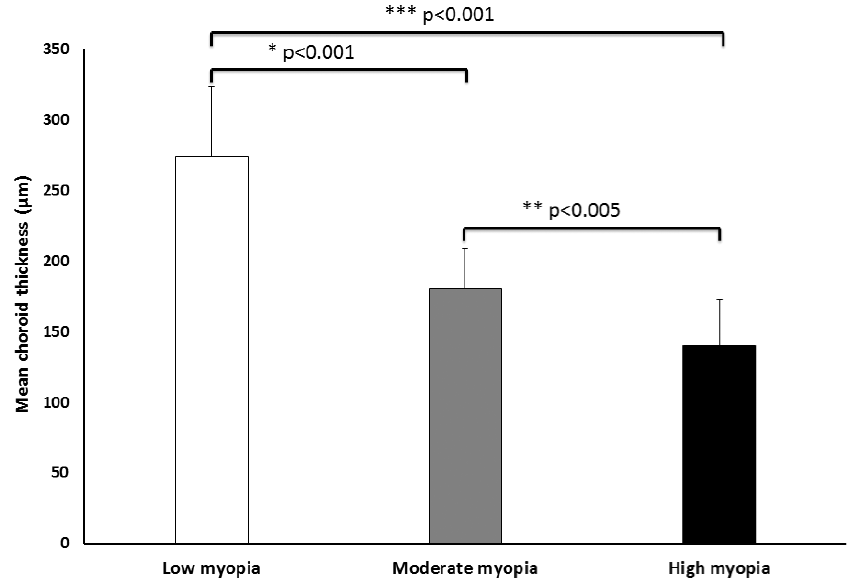
Fig. 9. CT changes under the fovea in low, moderate and high myopia. Data are presented as mean (cid:4)